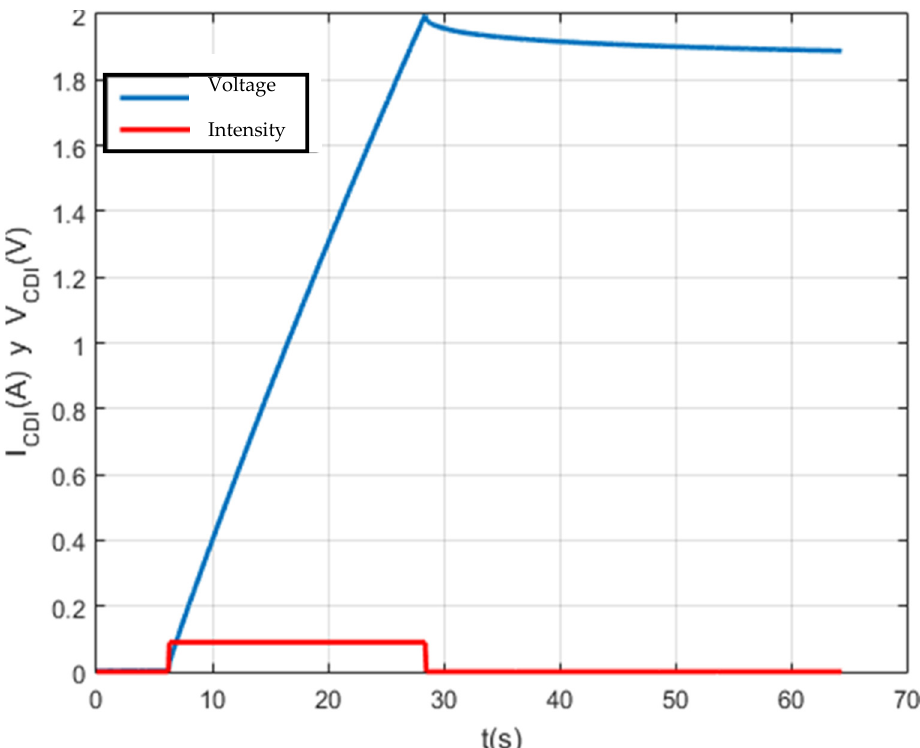
Figure 9 Charging and self-discharge test at Vc_max = 2 V and Ic = 0.1 A. Figure 9. Charging and self-discharge test at Vc_max = 2 V and Ic = 0.1 A. Membranes 2021 , 11 , x FOR PEER REVIEW